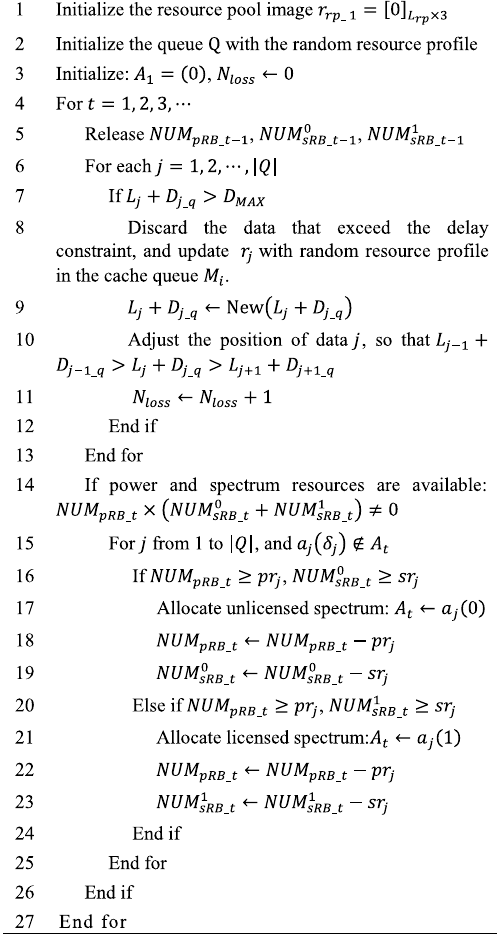
Algorithm 1 is a Greedy resource allocation method, expecting to transmit as many